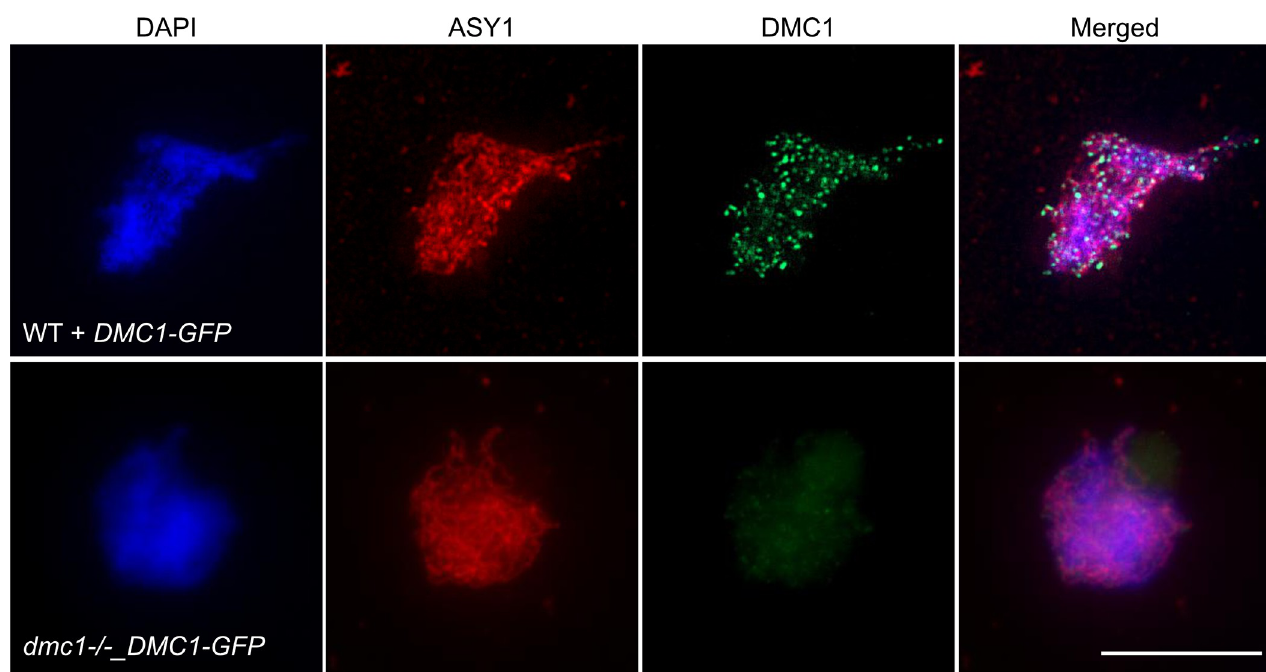
Fig 9. Immunolocalization of DMC1 in pDMC1 :: DMC1-GFP expressing plants. Male meiocytes were stained with DAPI (blue), anti-AtASY1 antibody (red), and anti-DMC1 antibody (green). Numerous DMC1 foci are visible on the chromosomes in WT plants expressing DMC1-GFP but not in dmc1-/- _DMC1-GFP . (Scale bar = 10 μ